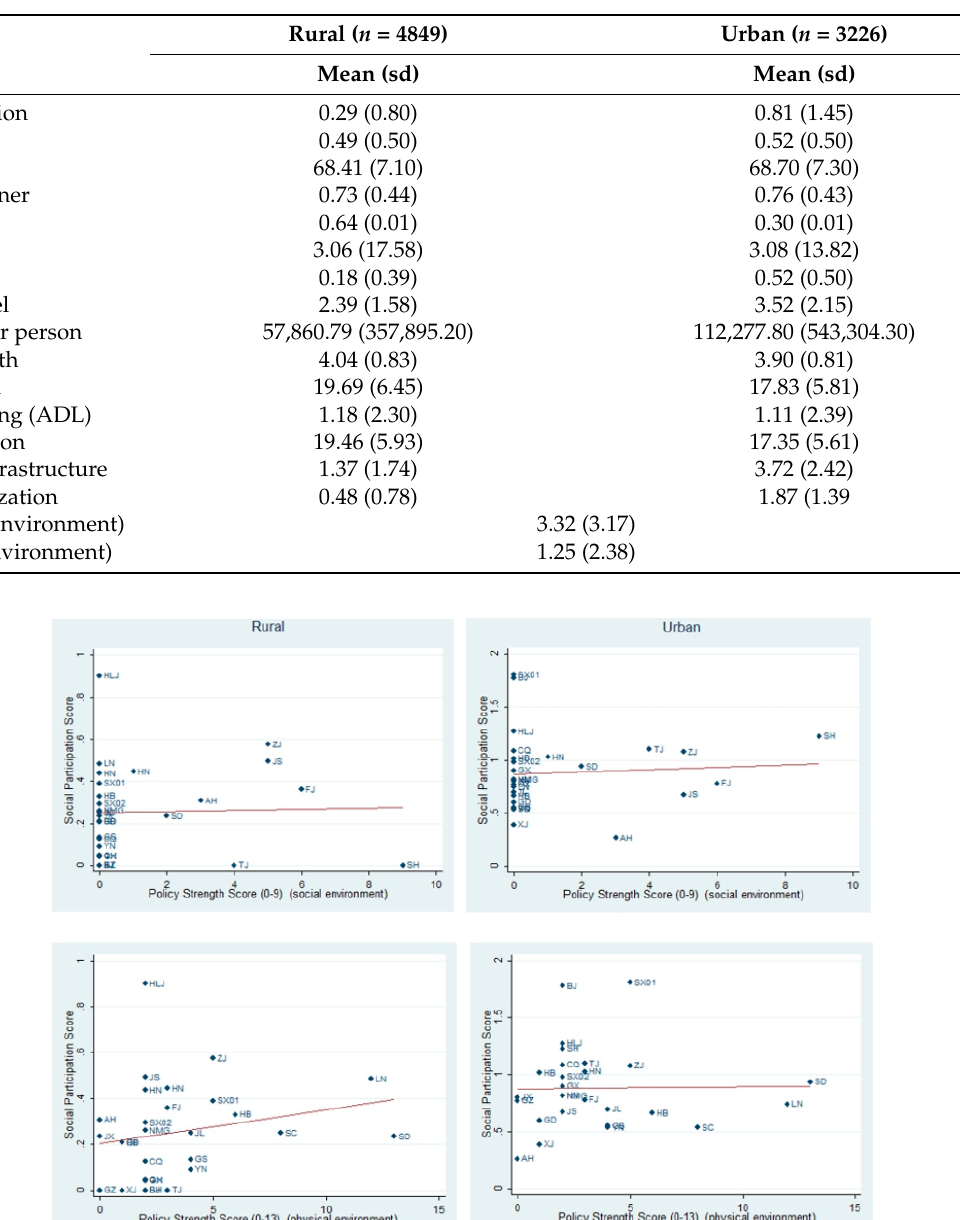
Table 2. Descriptive Sample statistics (unweighted).